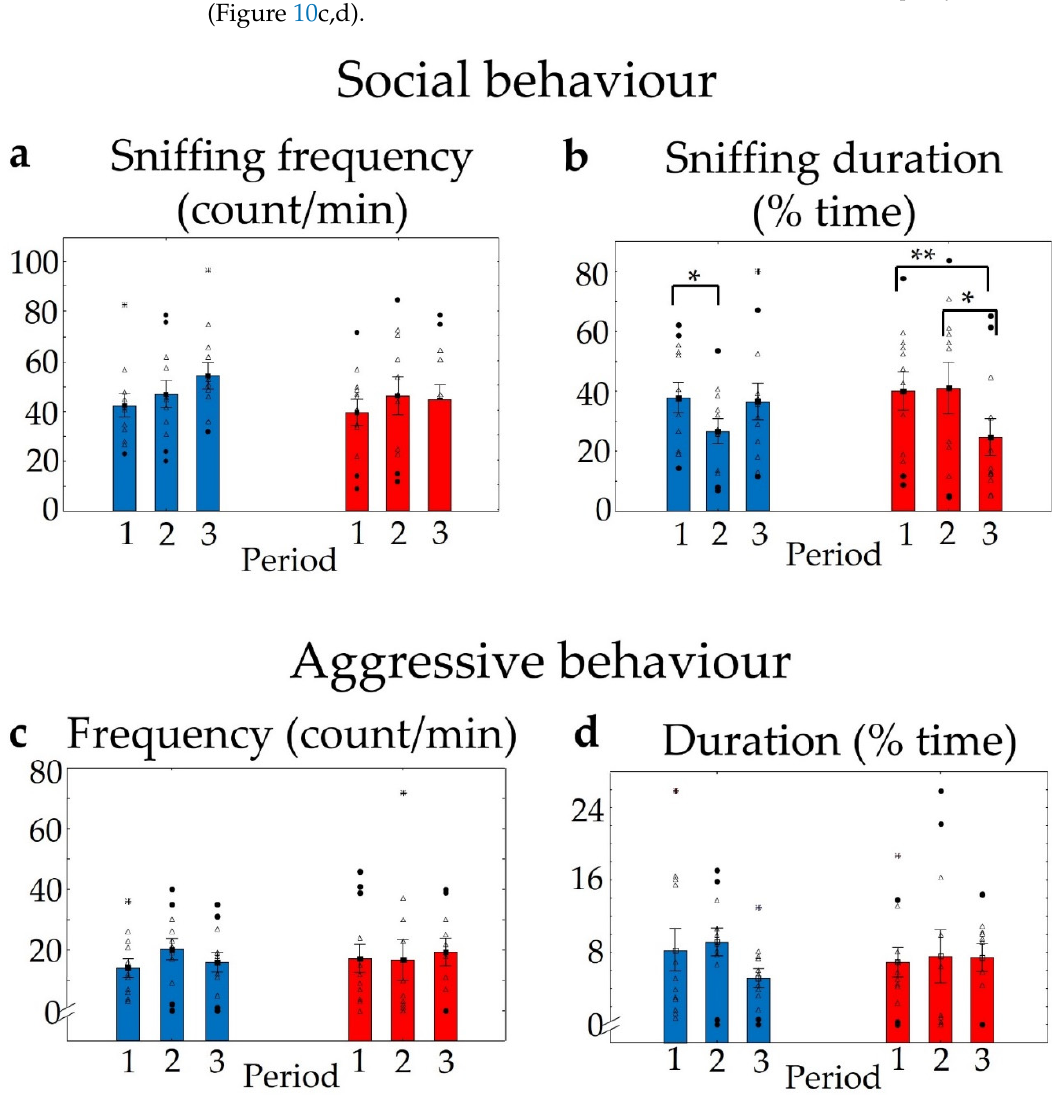
Figure 10. Results of resident–intruder trials. Numbers 1,2,3 represent 10 min trials 1 week apart. No significant differences were found in the frequency of social behaviour between the two genotypes ( a ). The duration of sniffing decreased significantly in both groups during the subsequent trials, although relevant temporal differences were detectable only in KOs ( b ). Neither the frequency nor the duration of aggressive interactions were significantly altered by time or by genotype ( c , d ). n = 12 in both groups, * p < 0.05 and ** p < 0.01 show a significant difference between repeated trials in the same group. Blank triangles represent individual values while dark spots show outliers (characterized by a higher or lower value than mean ± 2 standard deviation (SD)).